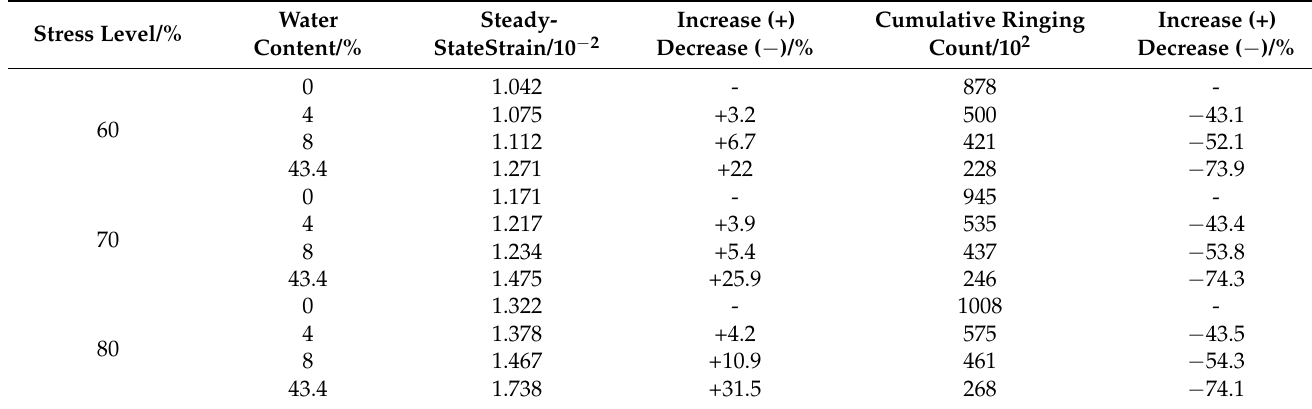
Table 4. AE ringing rate count variations.